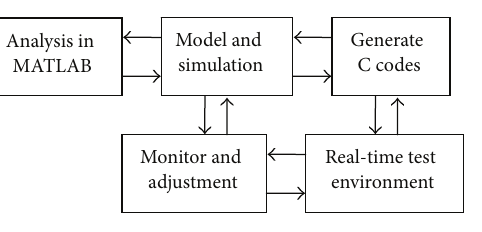
Figure 8: Working flow with RTW.